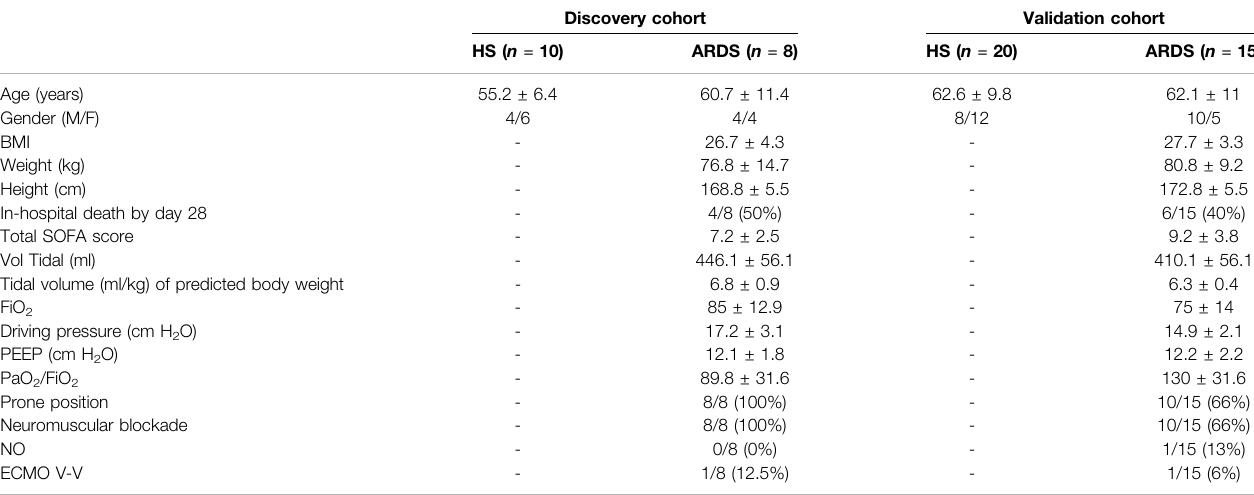
TABLE 1 | Clinical characteristics of the enrolled HSs and the ARDS patients.